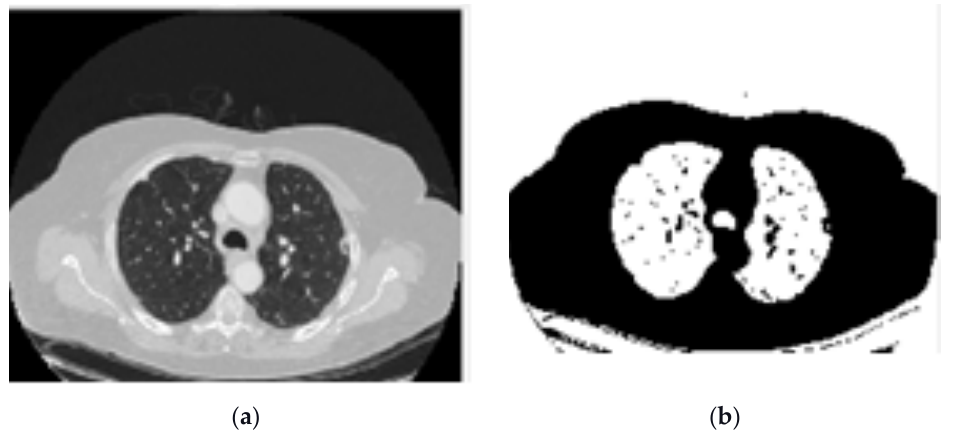
Figure 8. Image binarization process. ( a ) . Original CT, ( b ) .